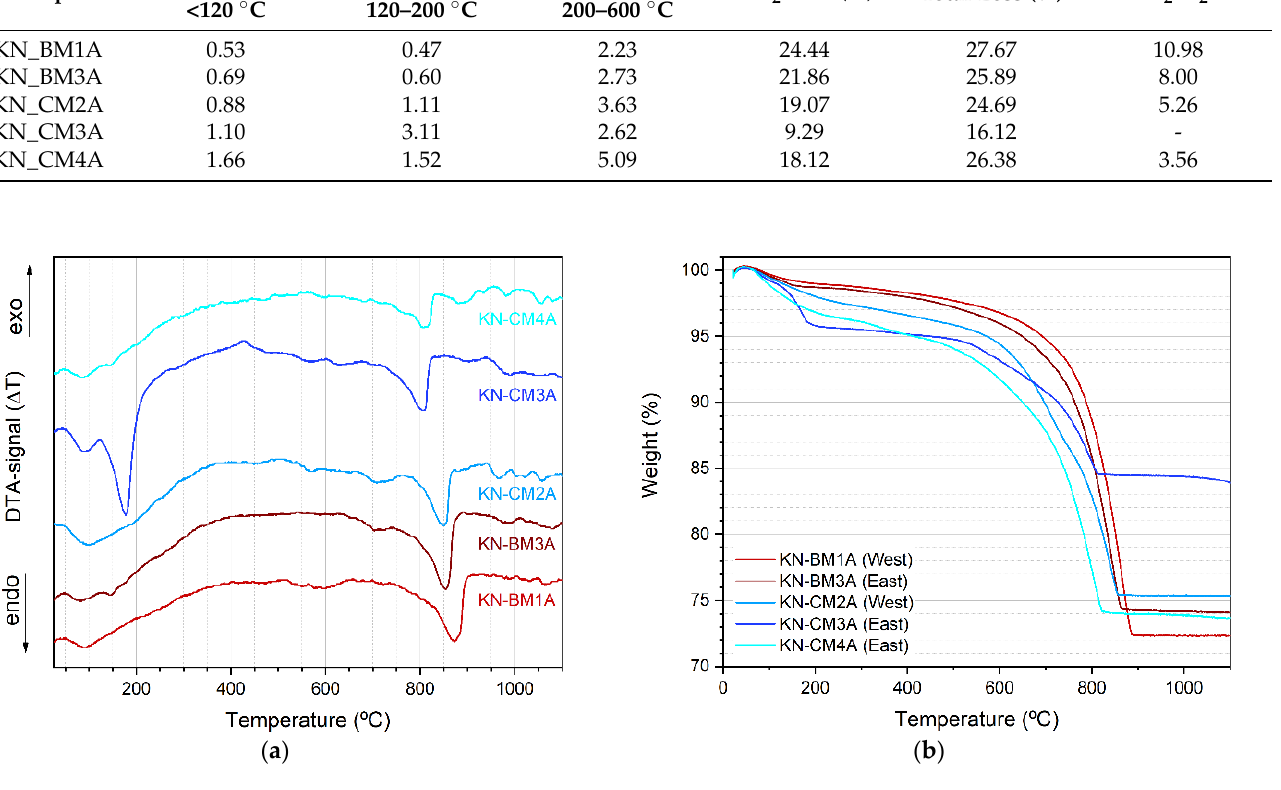
Figure 6. TG–DTA curves of mortar samples from the Palace of Knossos: ( a ) comparison of the curves obtained by differential thermal analysis, in which the curve referring to the KN-CM3A sample stands out, with the endothermic peak characteristic of dihydrate calcium sulfate; ( b ) comparison of the curves resulting from the thermogravimetric analysis, in which the similar trend for percentage of weight loss to all samples stands out, except for the KN-CM3A sample.